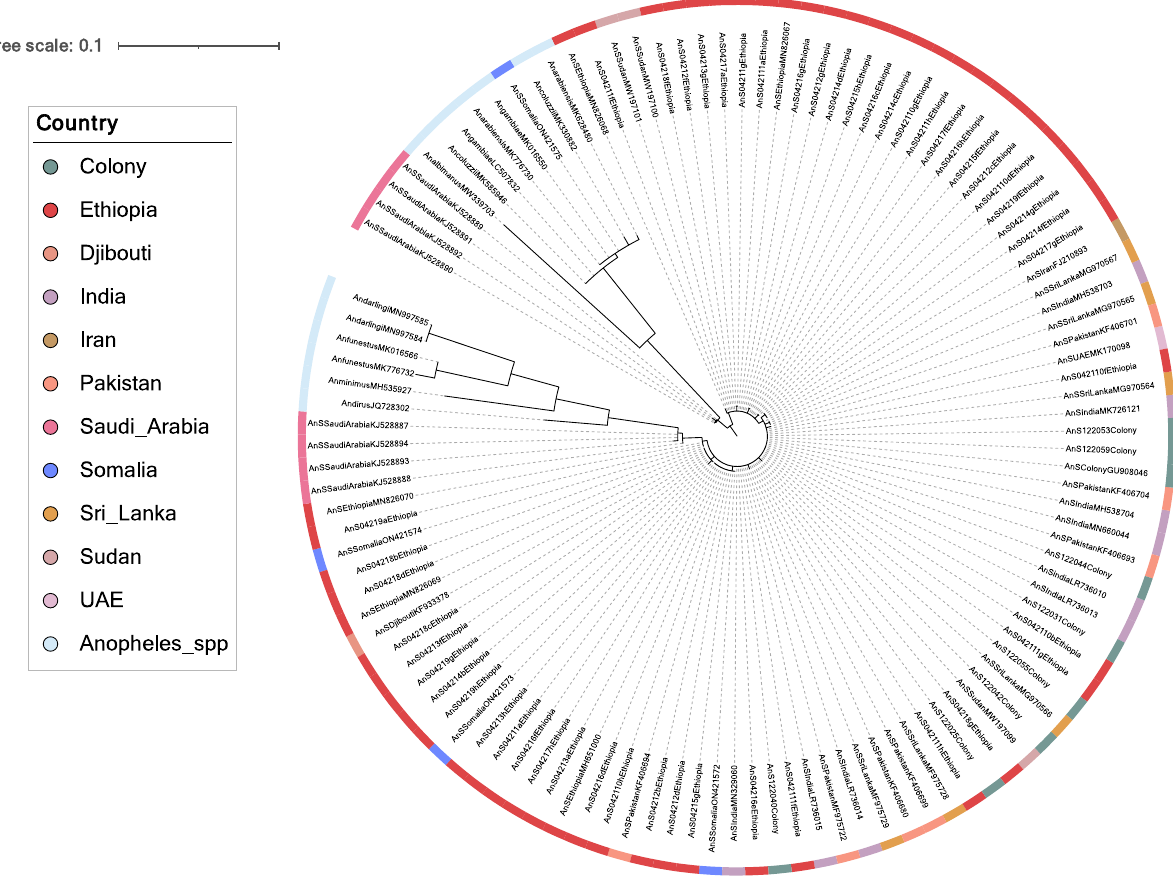
Figure 2. Neighbourhood joining tree constructed using cox1 gene sequences generated from this study, alongside publicly available sequence data from An. stephensi and a variety of other Anopheles spp . This includes An. albimanus, An. arabiensis, An. coluzzi, An. darlingi, An. dirus, An. funestus, and An. gambiae . The tree was built using the maximum-likelihood method assuming GTR model of nucleotide substitution, with the